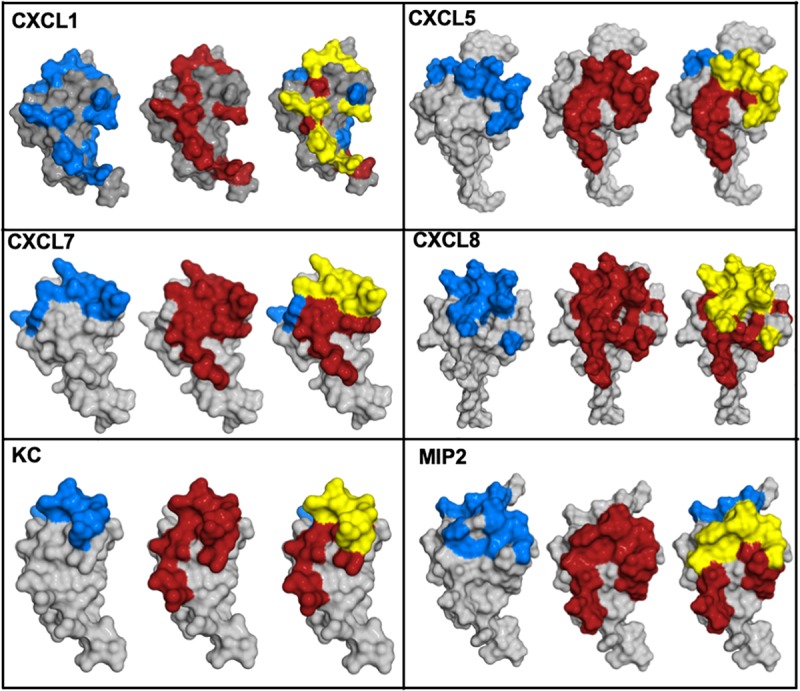
Chemokine structures showing GAG and receptor binding regions. Receptor-binding domains are in red, GAG-binding domains are in blue, and residues that are common to both are in yellow.